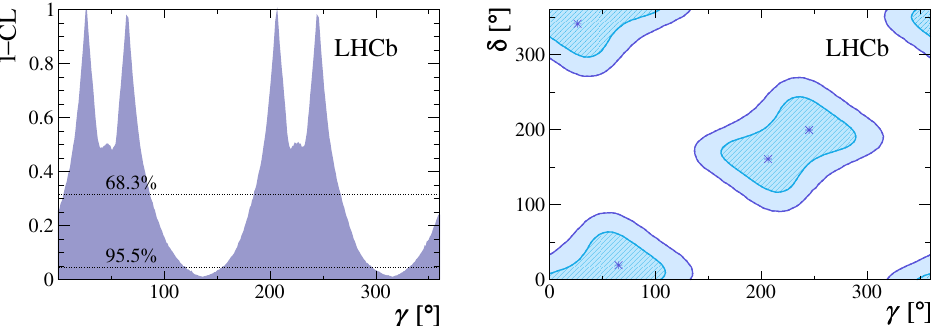
Figure 6 . (Left) 1{CL as a function of (cid:13) and (right) con(cid:12)dence regions for (cid:13) and (cid:14) . The con(cid:12)dence regions hold the 39% and 87% CL. Points denote the preferred